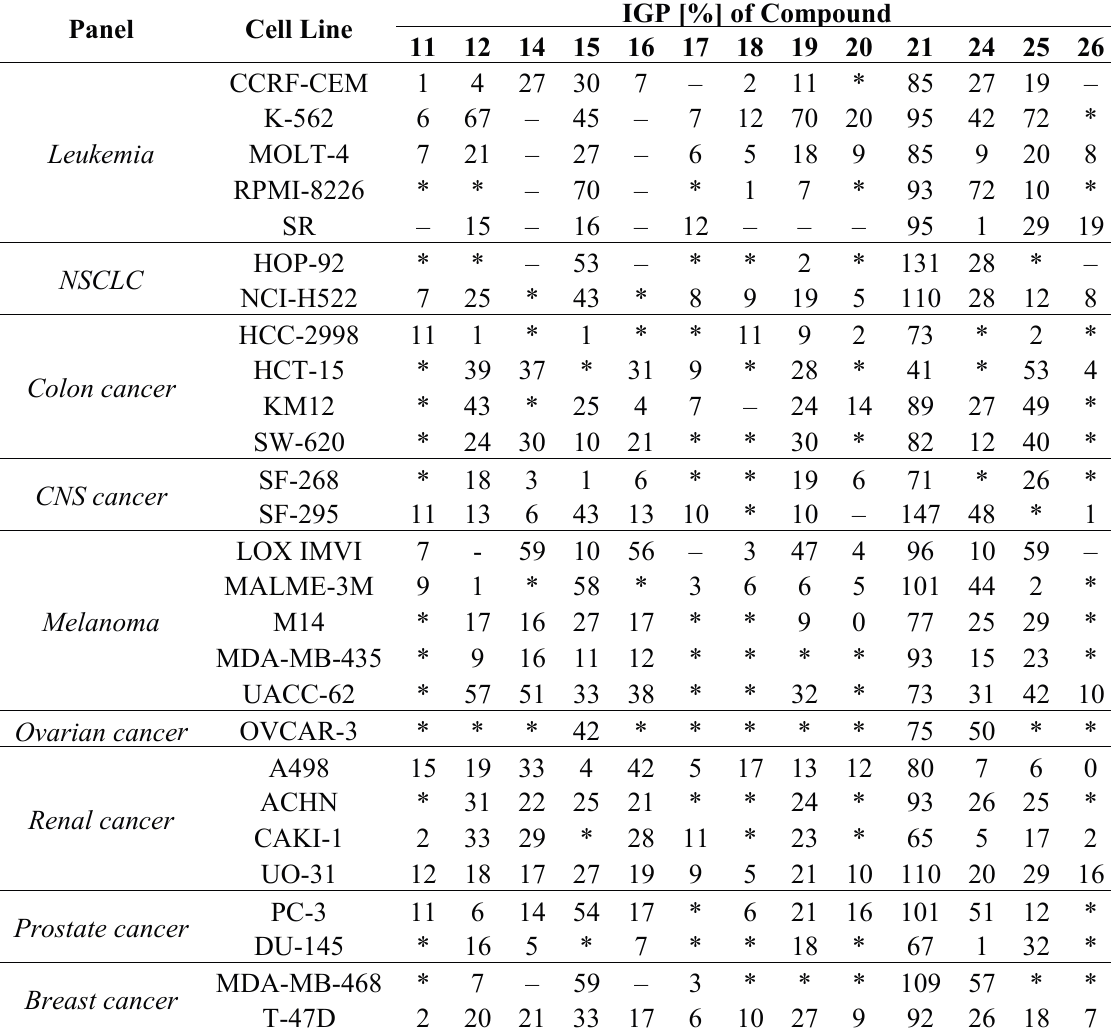
against selected NCI-60 cancer cell lines at single concentration 10 − 5 M.